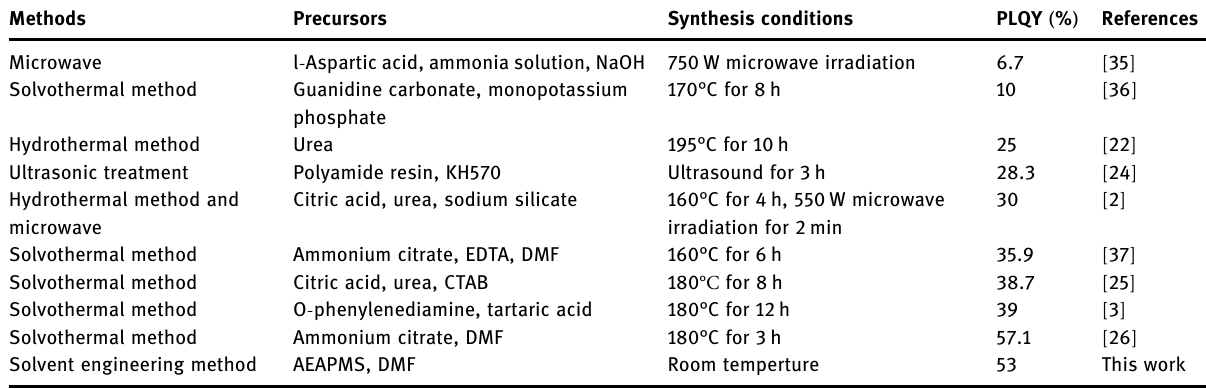
Table 1: Comparison of di ff erent methods for synthesizing SCWE - CQDs